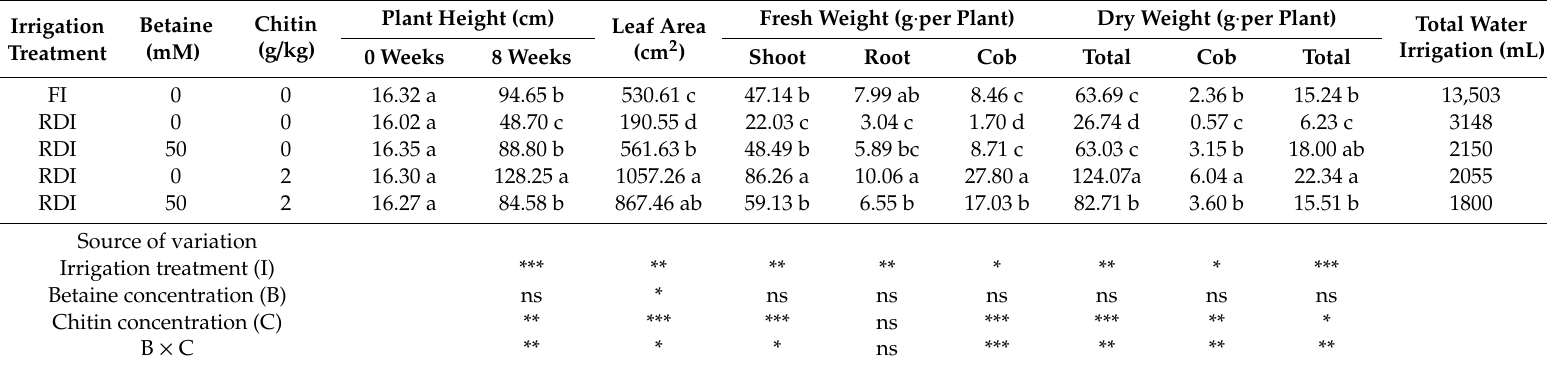
Table 5. E ff ects of di ff erent concentrations of betaine and chitin on the agronomic performance of maize under full irrigation (FI) and regulated deficit irrigation (RDI). Irrigation Treatment